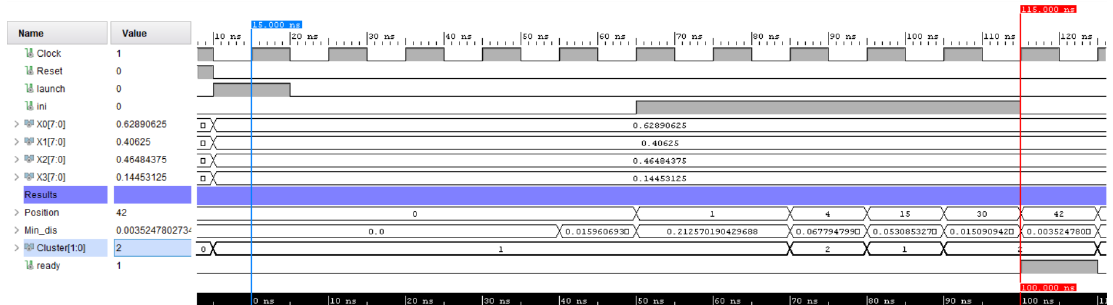
Figure 17. Simulation results of the SOM HW accelerator obtained with the Vivado design